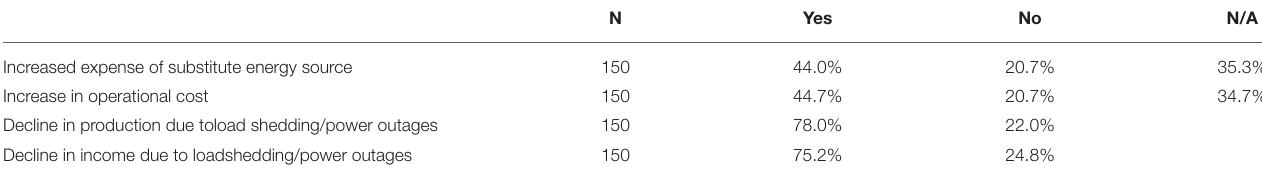
TABLE 6 | Perceptions on impact of load